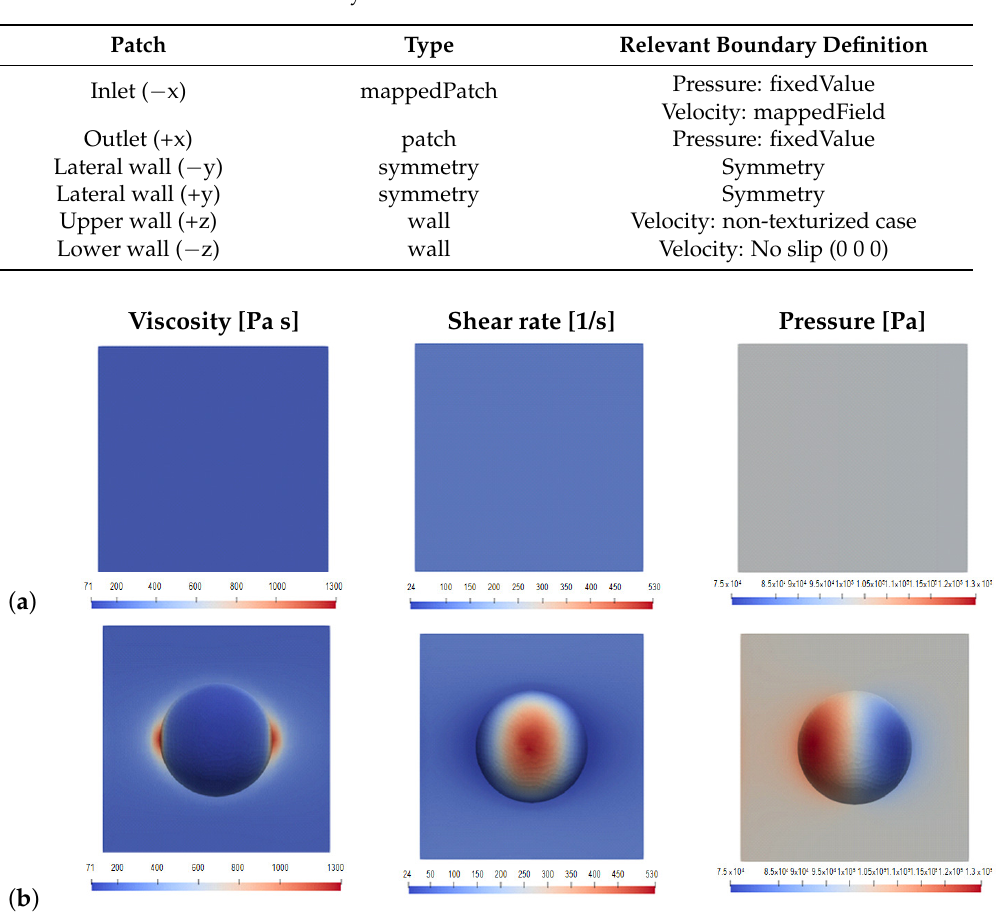
Figure 4. Flow on a representative domain near the wall, contours of viscosity, shear rate and pressure on the domain base (@ T = 450K & ∆ p = 1000 Pa): ( a ) smooth wall; ( b ) textured